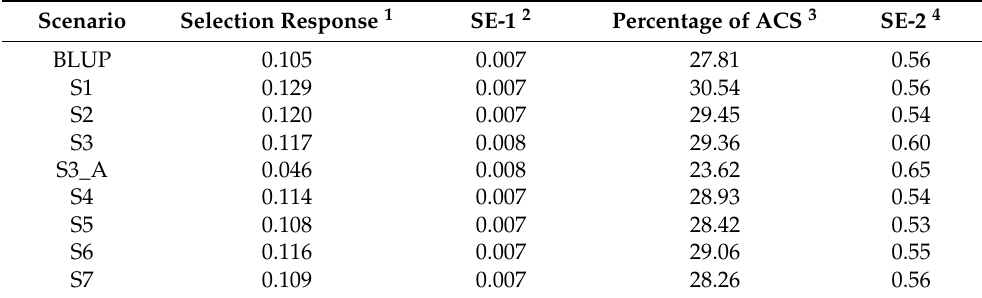
Table 3. Response to genomic selection and percentages of correctly selected animals across QTN models for each scenario.